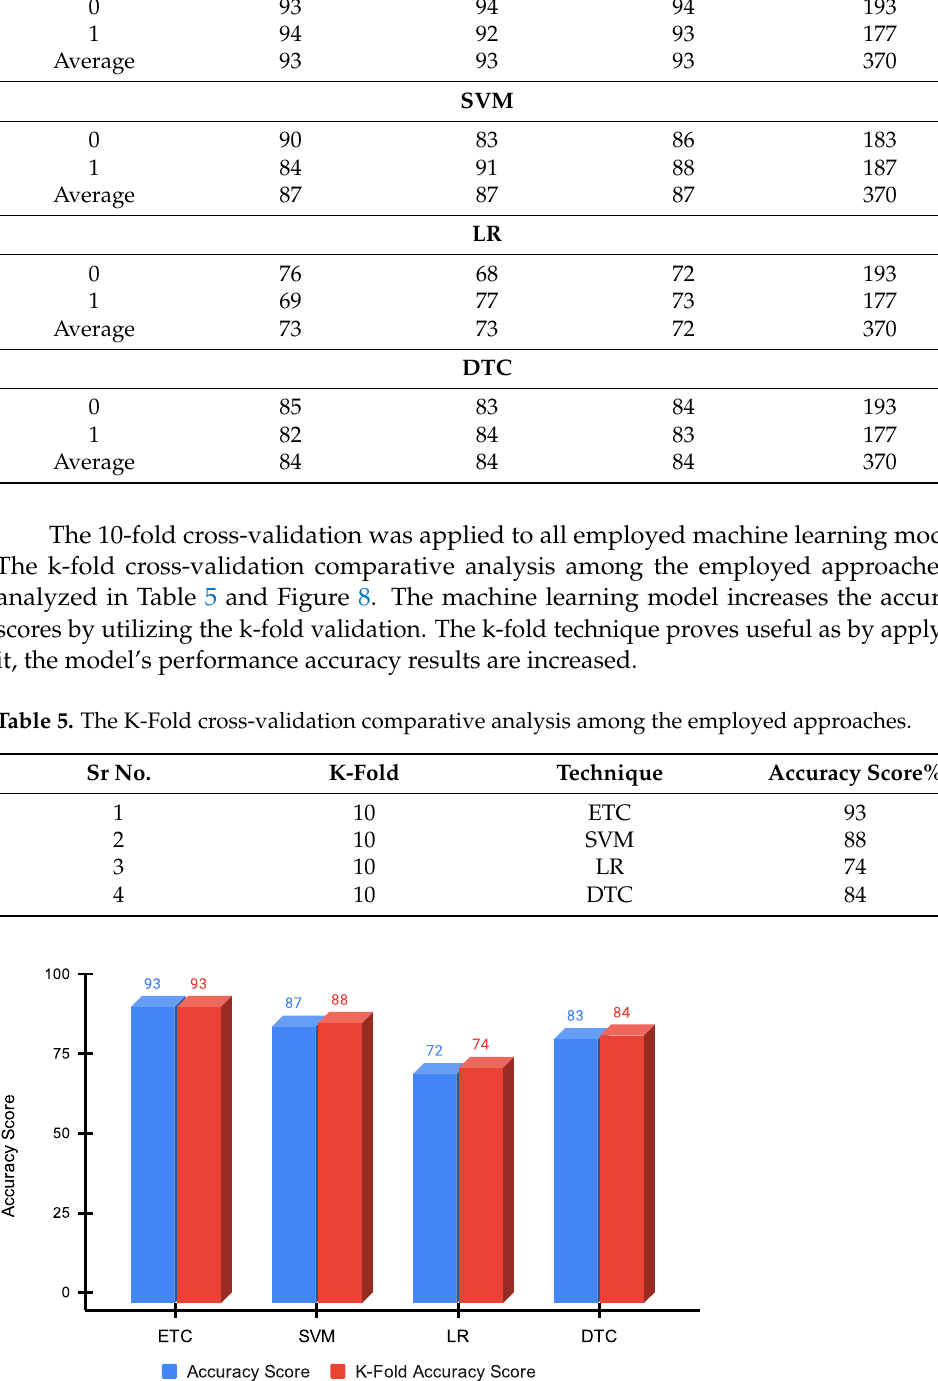
Table 6. The proposed ETC approach performance metrics results in evaluations. Proposed Technique